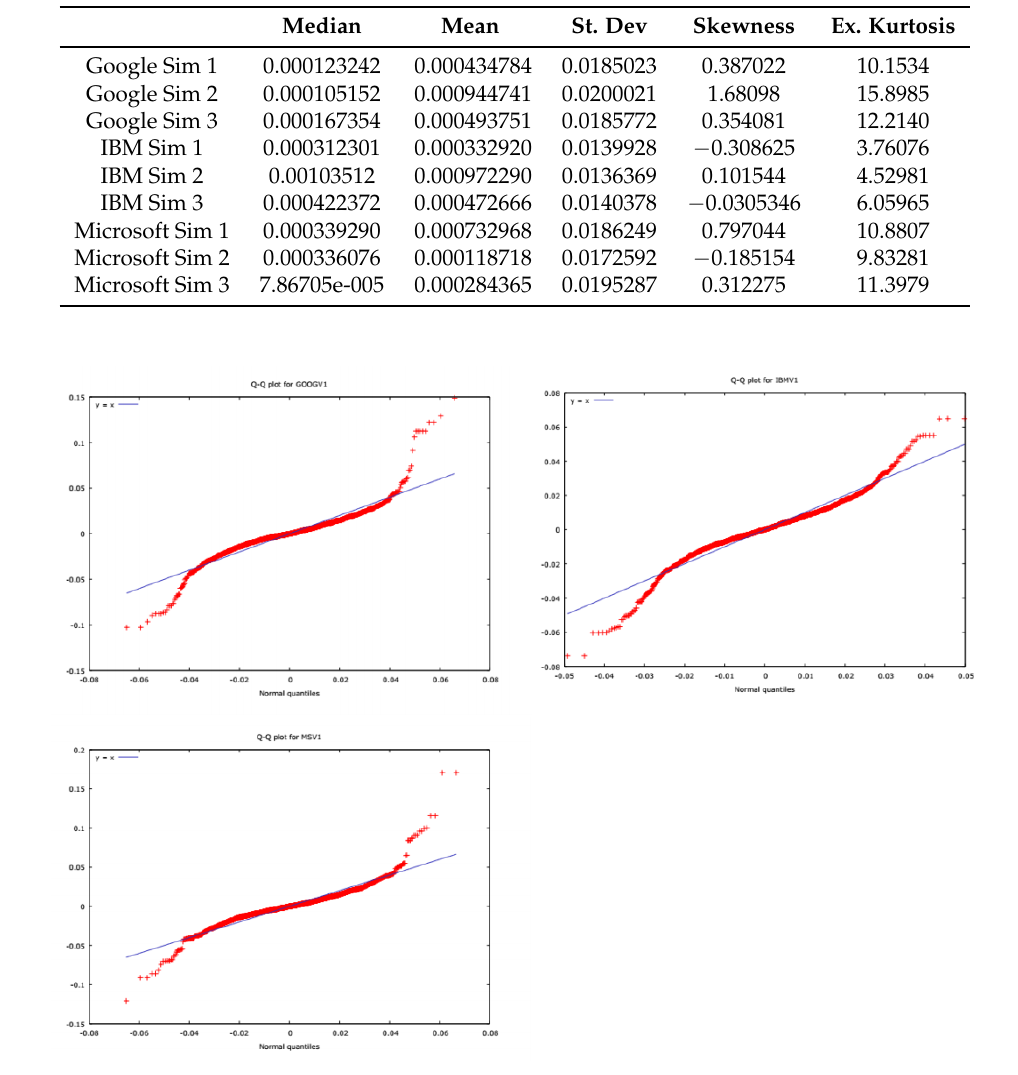
Table 3. Descriptive statistics of the simulated series.